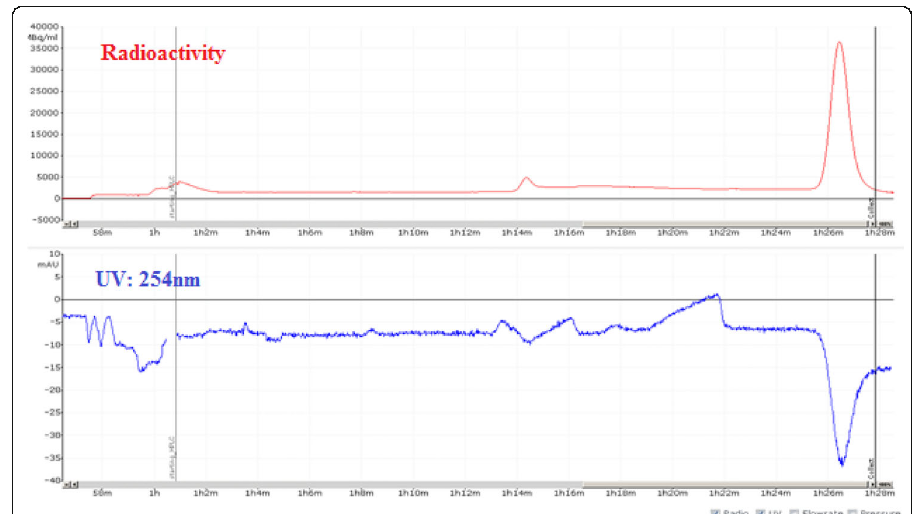
Fig. 13 A view of typical semi-preparative chromatogram of [ 18